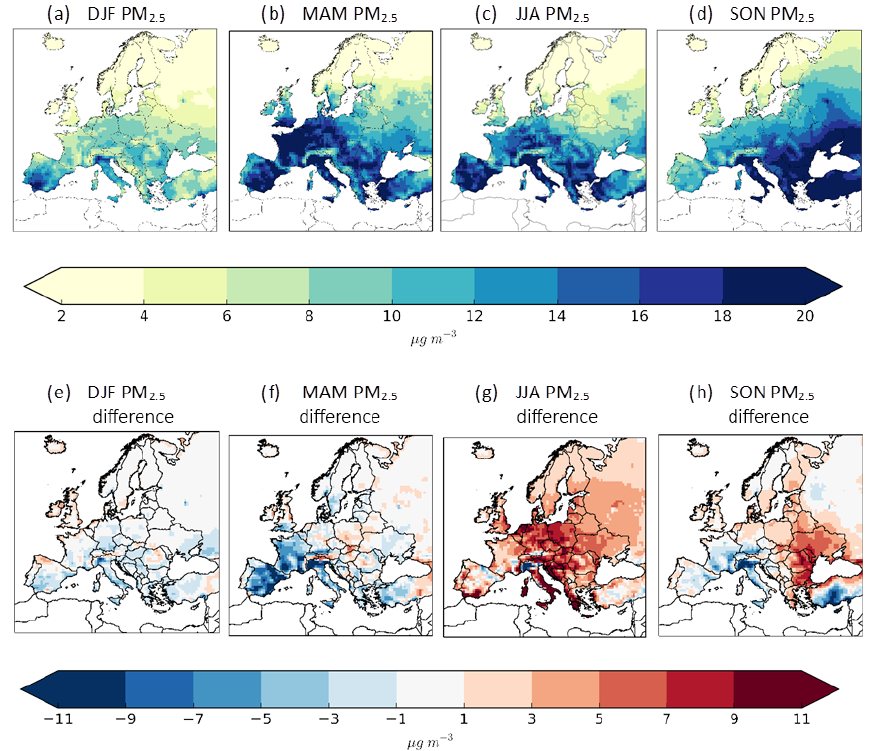
Figure 4. Seasonal mean PM 2 . 5 simulated at the finer resolution (a–d) , and differences between seasonal mean PM 2 . 5 at the coarse and finer resolution in 2007 (PM 2.5 coarse resolution − PM 2.5 finer resolution ) (e–h)